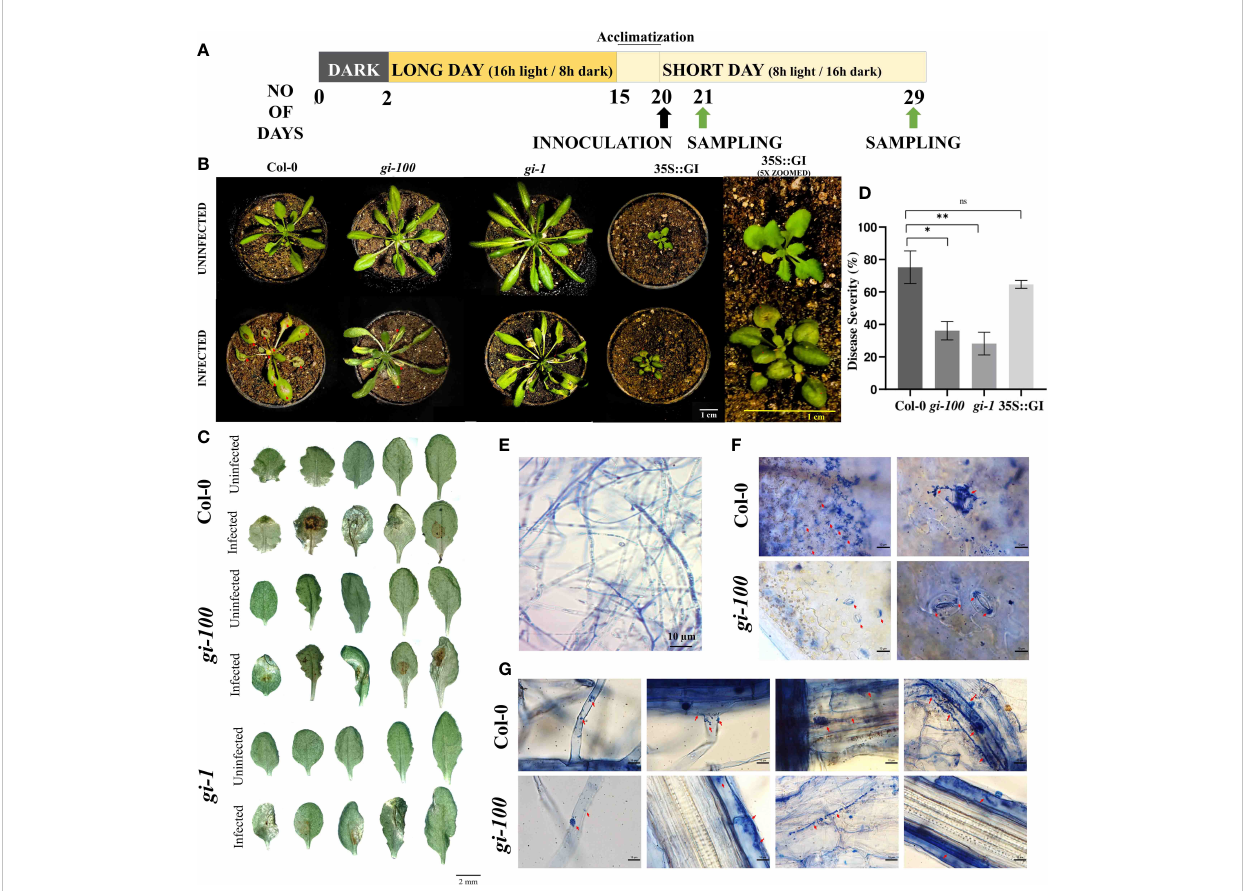
FIGURE 1 Effect of F. oxysporum infection on GIGANTEA (GI) in Arabidopsis thaliana . (A) Schematic representation of light treatment, plant growth conditions, and sample harvest. (B) Plant in pots infected with wilt disease caused by F. oxysporum . Columbia-0 (Col-0), gigantea mutant ( gi-100, gi-1 ), and overexpressed GI (35S::GI) plants after 9 and 5 days post inoculation (DPI), respectively. (C) Leaf morphology of Col-0, gi-100 , and gi-1 mutant plants after 9 DPI infected with F. oxysporum . The leaves of infected and uninfected plants were excised 9 DPI and were photographed using a Carl Zeiss stereo microscope. (D) Disease progression after F. oxysporum inoculation in Col-0 and gi-100 was interpreted as in disease severity percentage (area in square meters of necrosis). The disease severity was analyzed using ImageJ software as described in Materials and methods . (E) Viability of fungal hyphae of F. oxysporum was reclaimed by staining with trypan blue before infection. (F) Fungal invasion in Col-0 and gi-100 stained with trypan blue in leaf mesophyll cells in the upper row and lower row, respectively. Magni fi cation is indicated on the top right of each fi gure. (G) Progression of fugal hyphae from lateral hair cells to tap root cells (left to right) in Col-0: upper row and gi-100 : lower row visualized at 100×. Data presented as mean ± SE. Student ’ s paired t -test was used to evaluate signi fi cant differences and compared between Col-0 and gi-100 plants. * p < 0.05, ** p < 0.01, ns, Non-signi fi